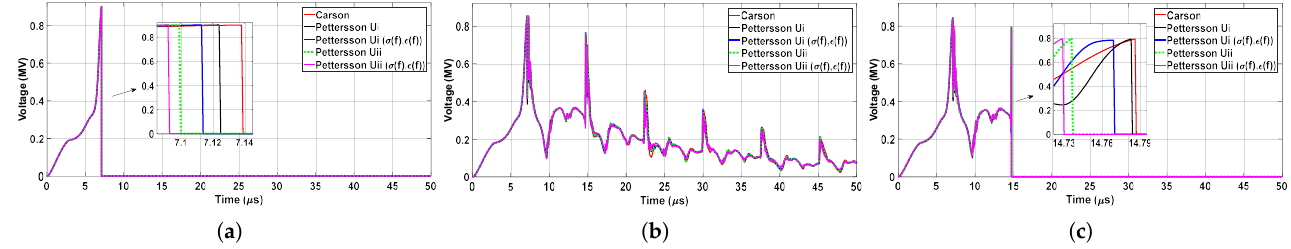
Figure 15. Overvoltage waveforms in phases A ( a ), B ( b ) and C ( c ), with or without a disruption process (backflashover), considering ground resistivity equal to 1000 Ω .m and a lightning stroke current waveform with α =